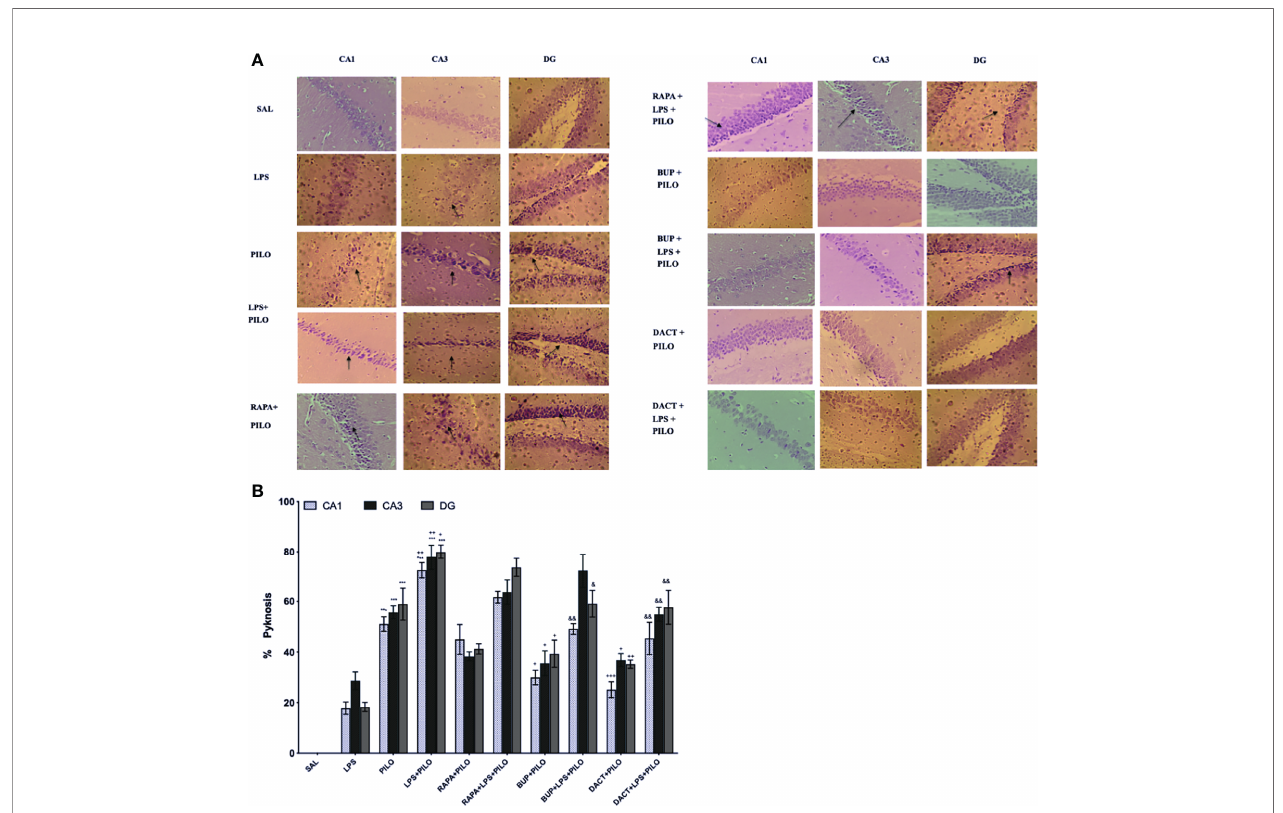
FIGURE 6 | Effect of LPS priming 2 h prior to PILO exposure on neurodegeneration in C57BL/6 hippocampi. The photomicrographs represented in the above fi gure show the CV stained hippocampus sections, i.e., CA1, CA3, and DG regions under higher magni fi cation (scale bar: 200 m m, n=3). The arrows represent signi fi cant pyknotic cells in those areas. The graph represents ***p<0.001 versus SAL, +++ p<0.001 versus PILO, ++ p<0.01 versus PILO, + p<0.05 versus PILO, && p<0.01 versus LPS+PILO, and & p<0.05 versus